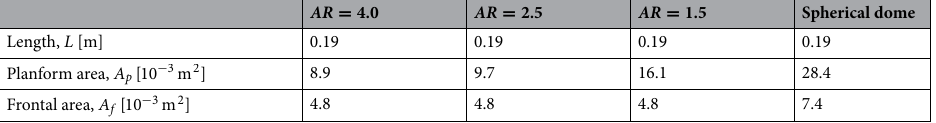
Table 2. Lengths and areas for experimental models. For the sea star models, L = 19 cm corresponds to the frontal width when one of the arms is oriented into the flow, (cid:31) = 0 ◦